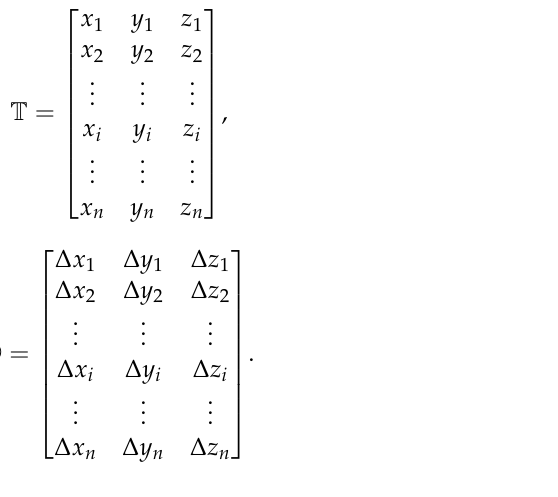
Table 1. Drone movements and corresponding conditions implemented in our algorithm. No. Distance Conditions (Pixels) Drone Movement